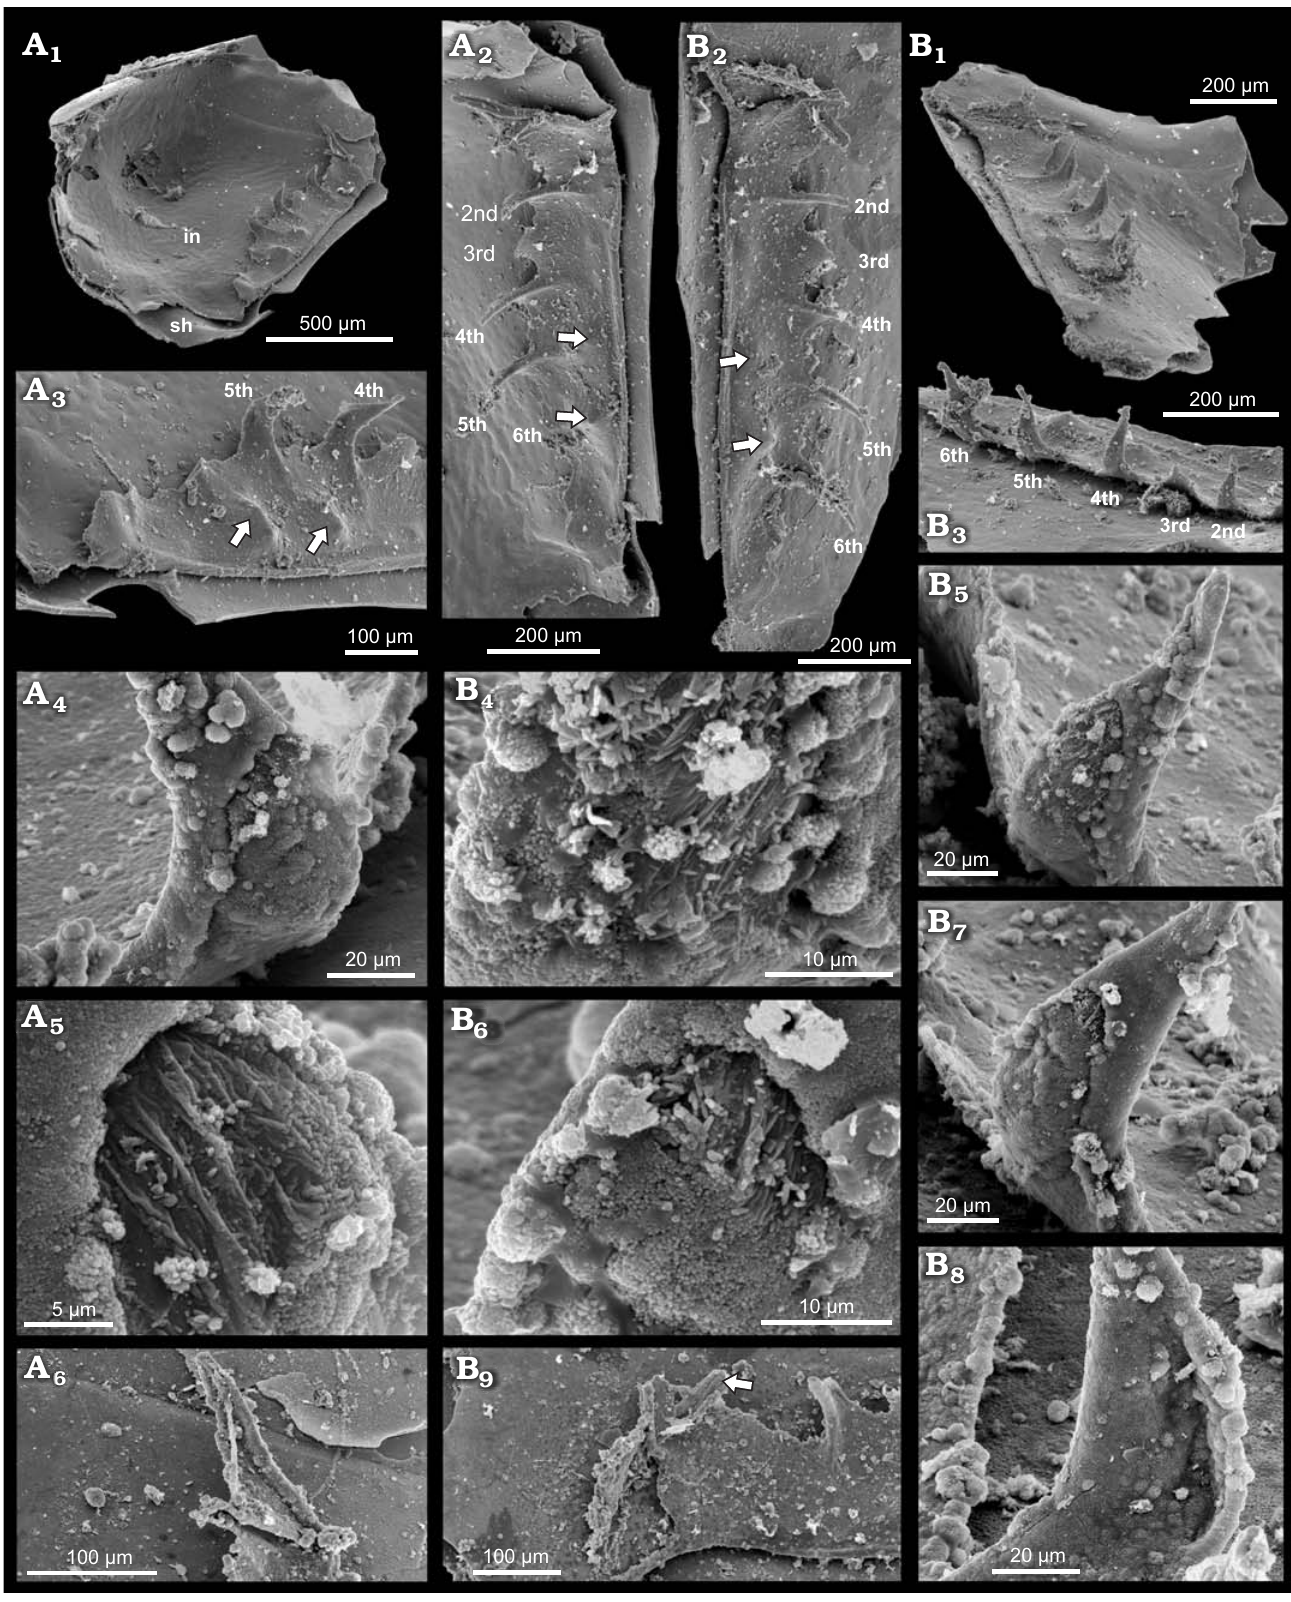
Fig. 7. Phosphatocopid crustacean Cyclotron sp. from Olenus Biozone, Furongian, D ę bki 2 borehole, northern Poland. A . ZPAL Cr.11/ph095. Internal view of right valve depicting shell, inner lamella and partly preserved cuticle with apodemes in dorsal part, anterior to the right (A 1 ); detailed view of A 1 exhibiting apodemes (numbers of supposed limbs: antenna (2nd), mandible (3rd) and three post-mandibular limbs (4th–6th) and structures interpreted as